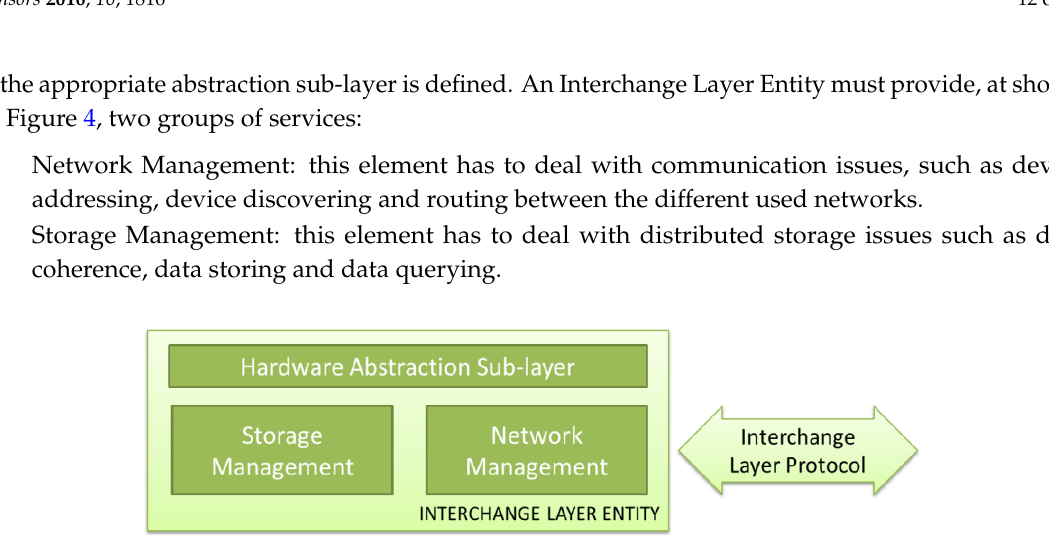
Figure 4. Detail of Interchange Layer Entity.